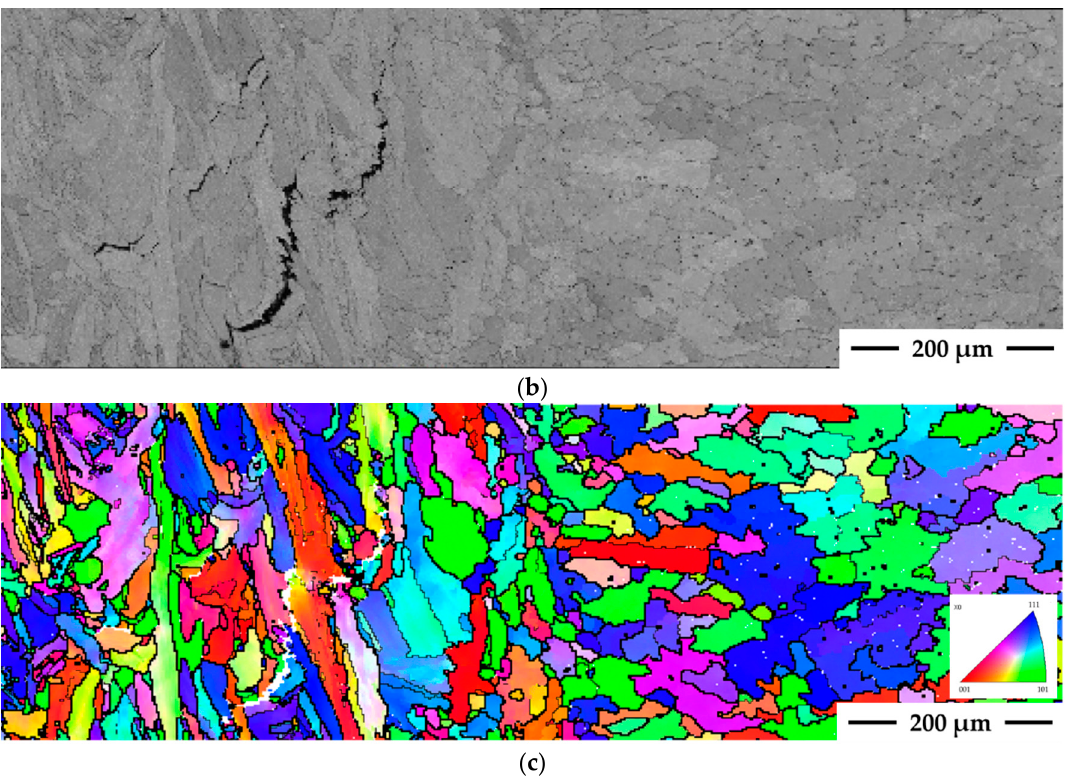
Figure 6. ( a ) Optical micrograph showing base metal (BM), heat affected zone (HAZ), partially melted zone (PMZ), and fusion zone (FZ) of the specimen welded parallel to the sample building direction (BD) (Note: the welding direction (WD) is parallel to the grain orientation). ( b ) SEM micrograph showing the unetched microstructure of the welded sample. ( c ) EBSD inverse pole figure (IPF) coloring mapping of the same image as ( b ).